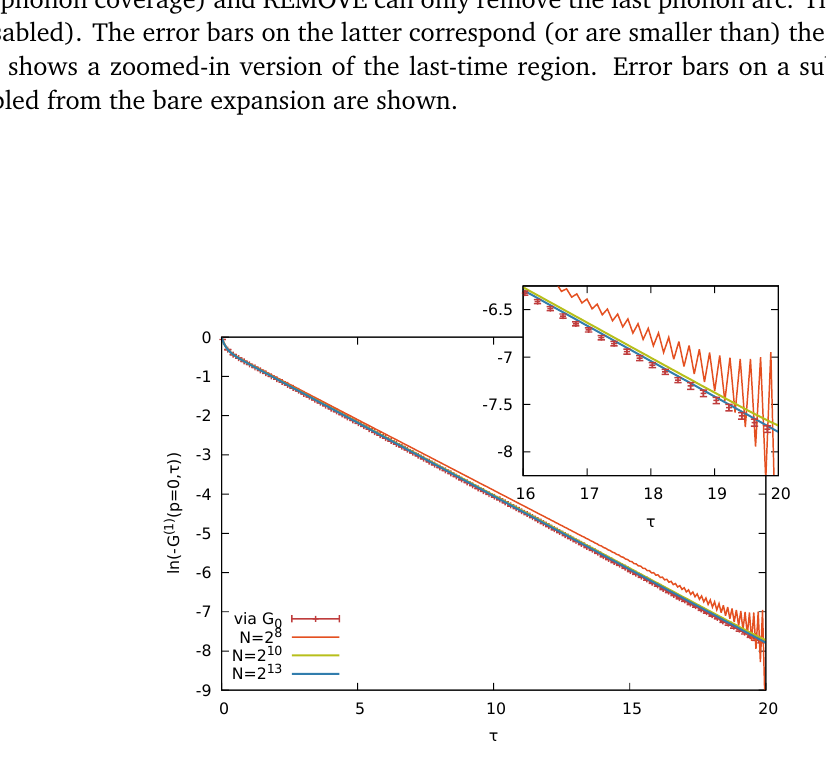
Figure 14: Same as in Fig. 13 but instead of the self-energy we compute the convolution (cid:112) ( Σ (cid:63) G )( τ ) for p = 0, which behaves as ∼ τ for τ → 0. Compared to Fig. 13, treating the 0 divergence of the self-energy more carefully allowed us to substantially reduce the required number of Matsubara